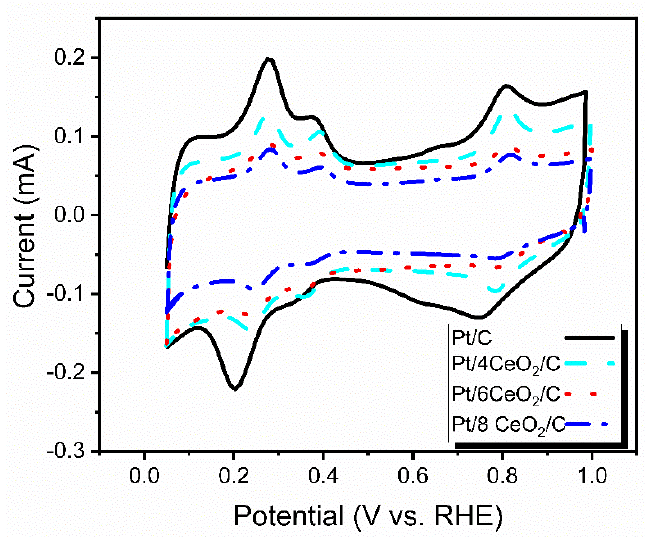
Figure 5. Cyclic voltammograms of Pt/C and Pt/CeO 2 /C catalysts in 0.1 mol L − 1 NaOH under Ar at room temperature and a scan rate of 50 mVs − 1 .